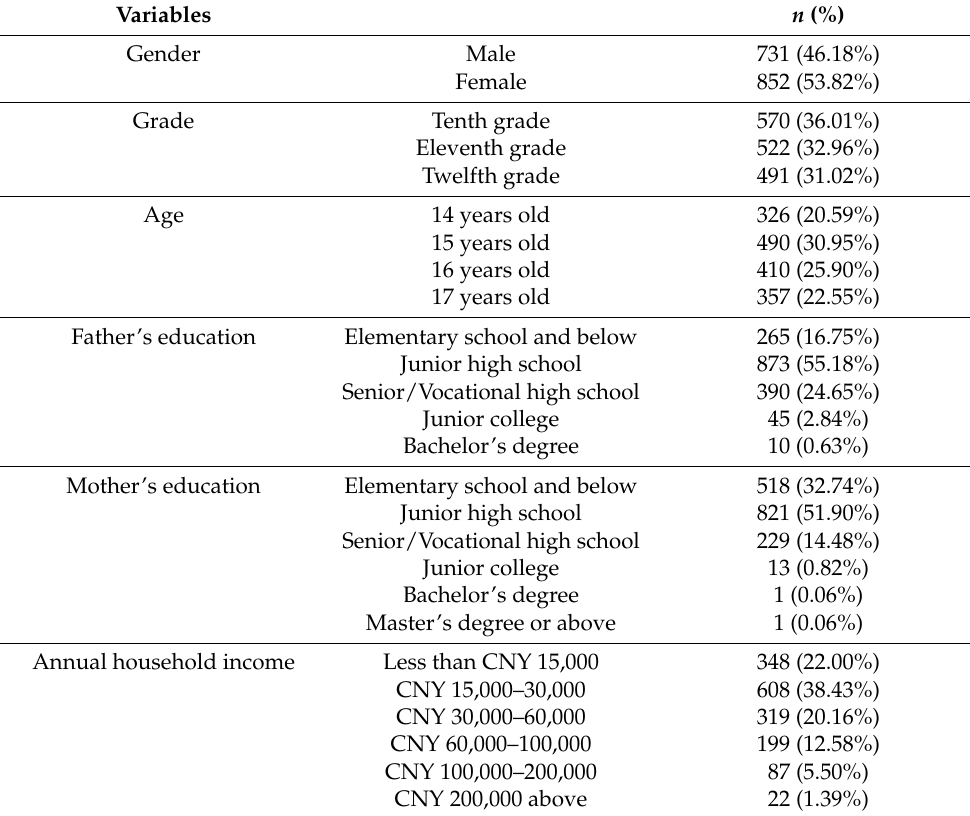
Table 1. Demographic information of participants ( n =